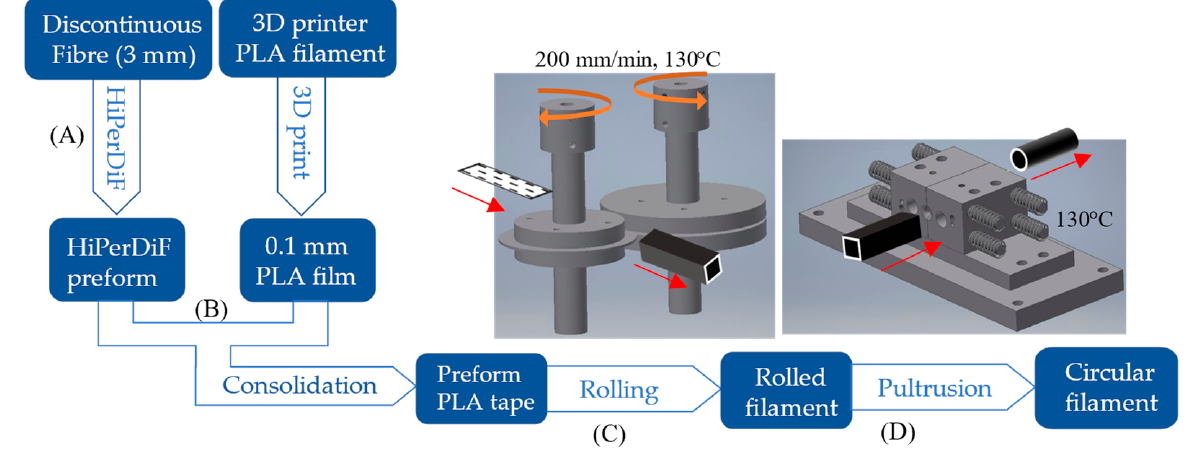
Figure 1. Overall DcAFF filament forming process starting from ( A ) HiPerDiF preform fibre and thin PLA matrix preparation, ( B ) consolidation of HiPerDiF preform and PLA tape, ( C ) bulking tape by designed rolling technique, and ( D ) pultrusion through a series of nozzles.